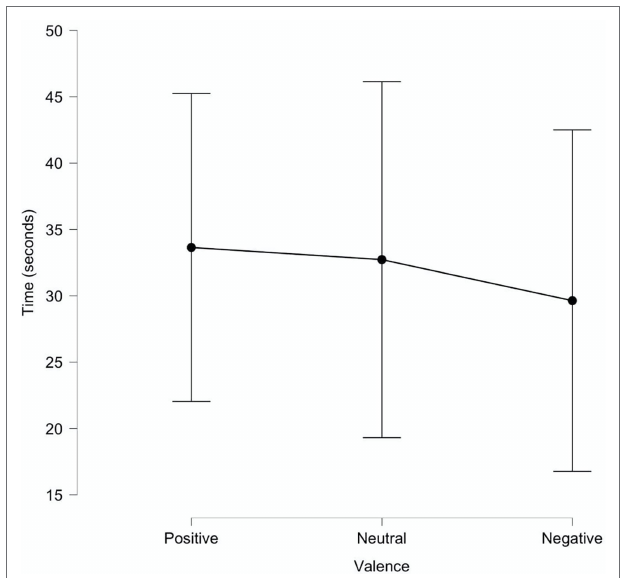
FIGURE 5 | Time spent on